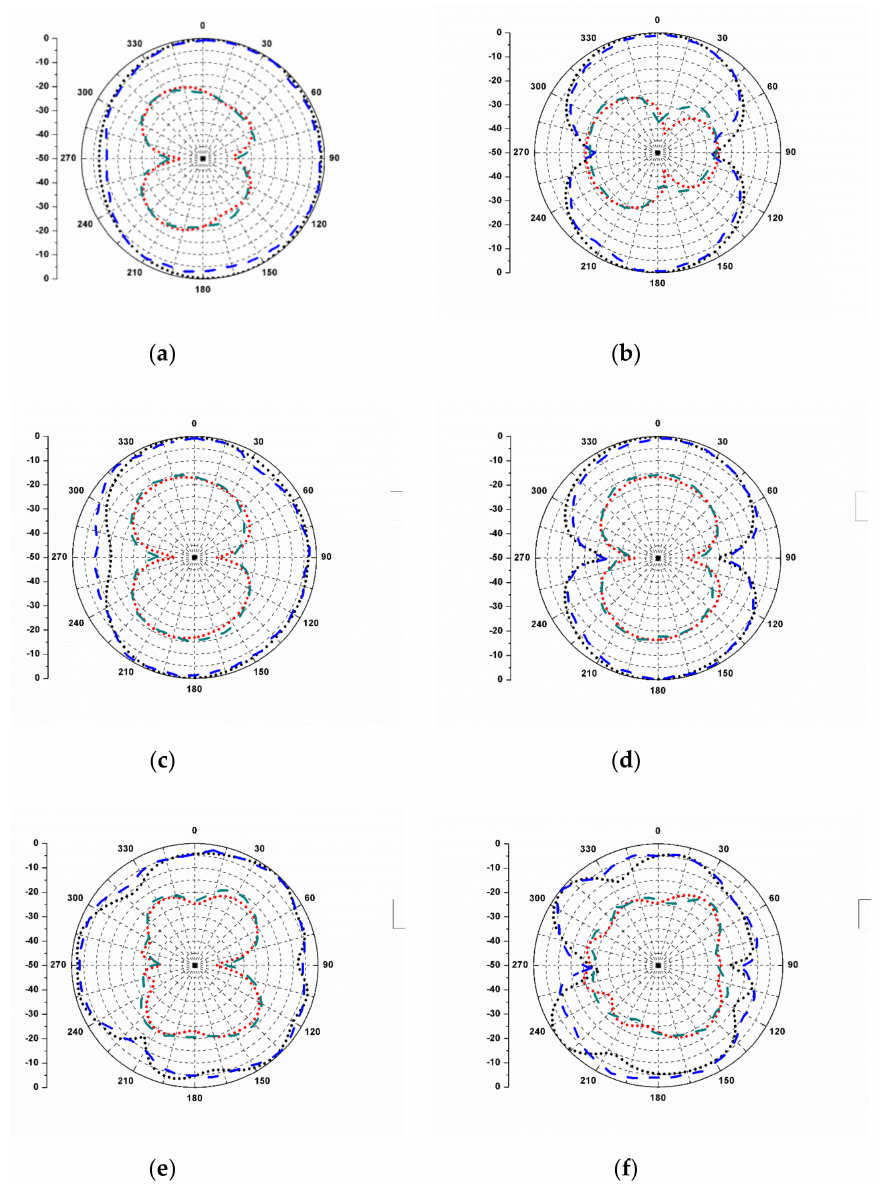
Figure 12. Radiation patterns of the proposed antenna: ( a ) H-plane / 2.5 GHz; ( b ) E-plane / 2.5 GHz; ( c ) H-plane / 7.5 GHz; ( d ) E-plane / 7.5 GHz; ( e ) H-plane / 12 GHz; and ( f ) E-plane / 12